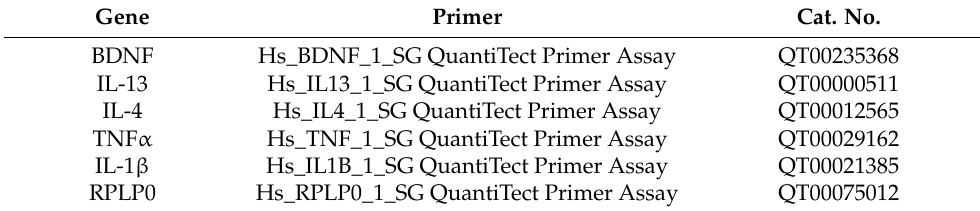
Table 1. Primers used for